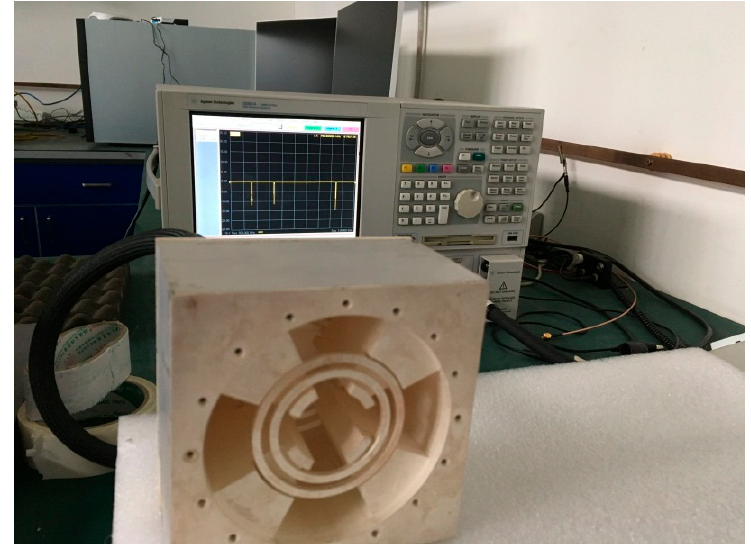
Figure 4. Measurement of the reflection characteristic of the strapped resonator.